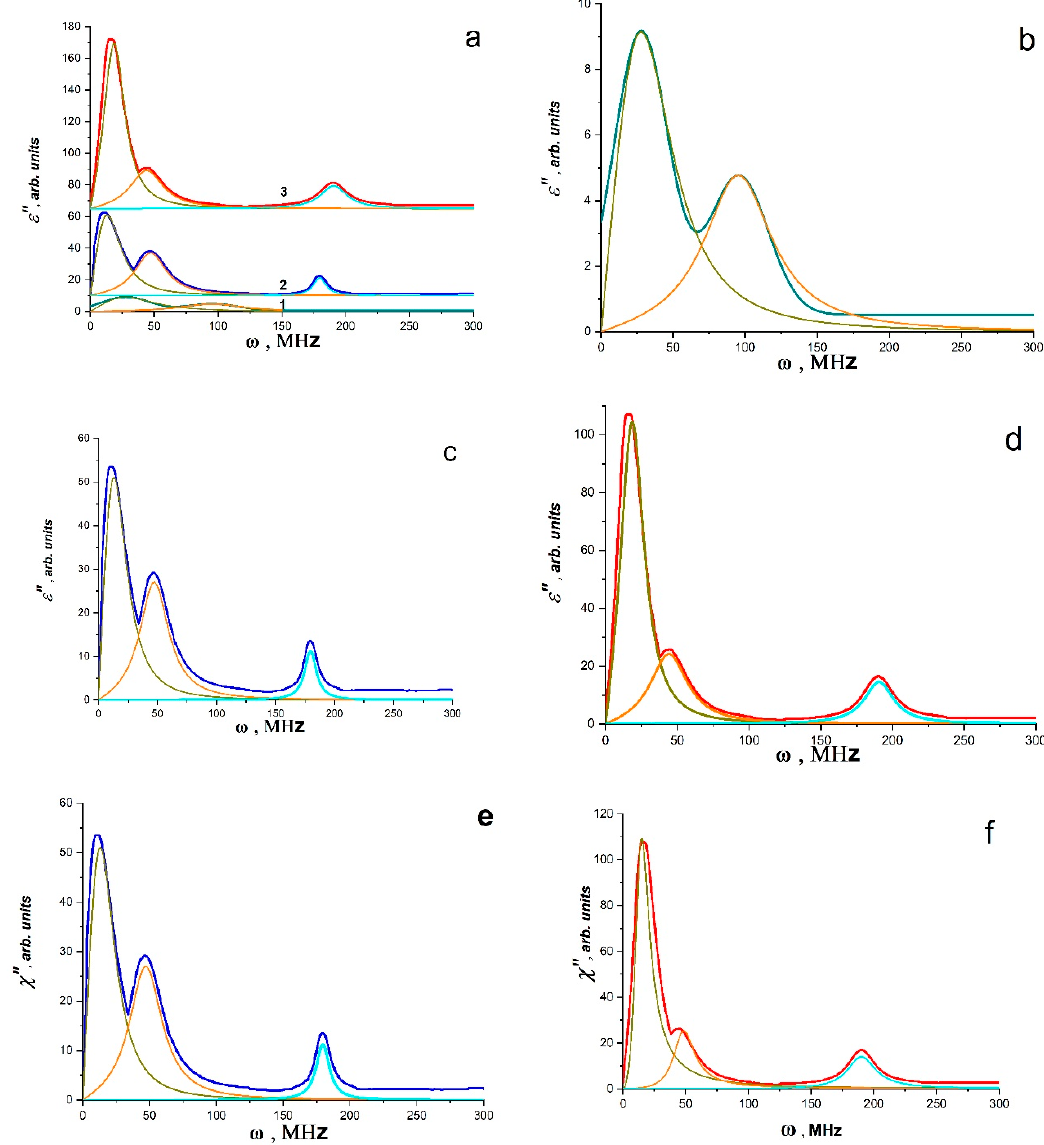
Figure 7. ( a ) Fourier images of electrical signals of PS matrix (1), PS–BC Co (2) and PS–BC Mn (3); absorption bands obtained for PS matrix ( b ), PS–BC Co ( c ) and PS–BC Mn ( d ) by the Lorentz method and absorption bands for PS–BC Co ( e ) and PS–BC Mn ( f ) obtained by the LLB method (From [48] with permission).